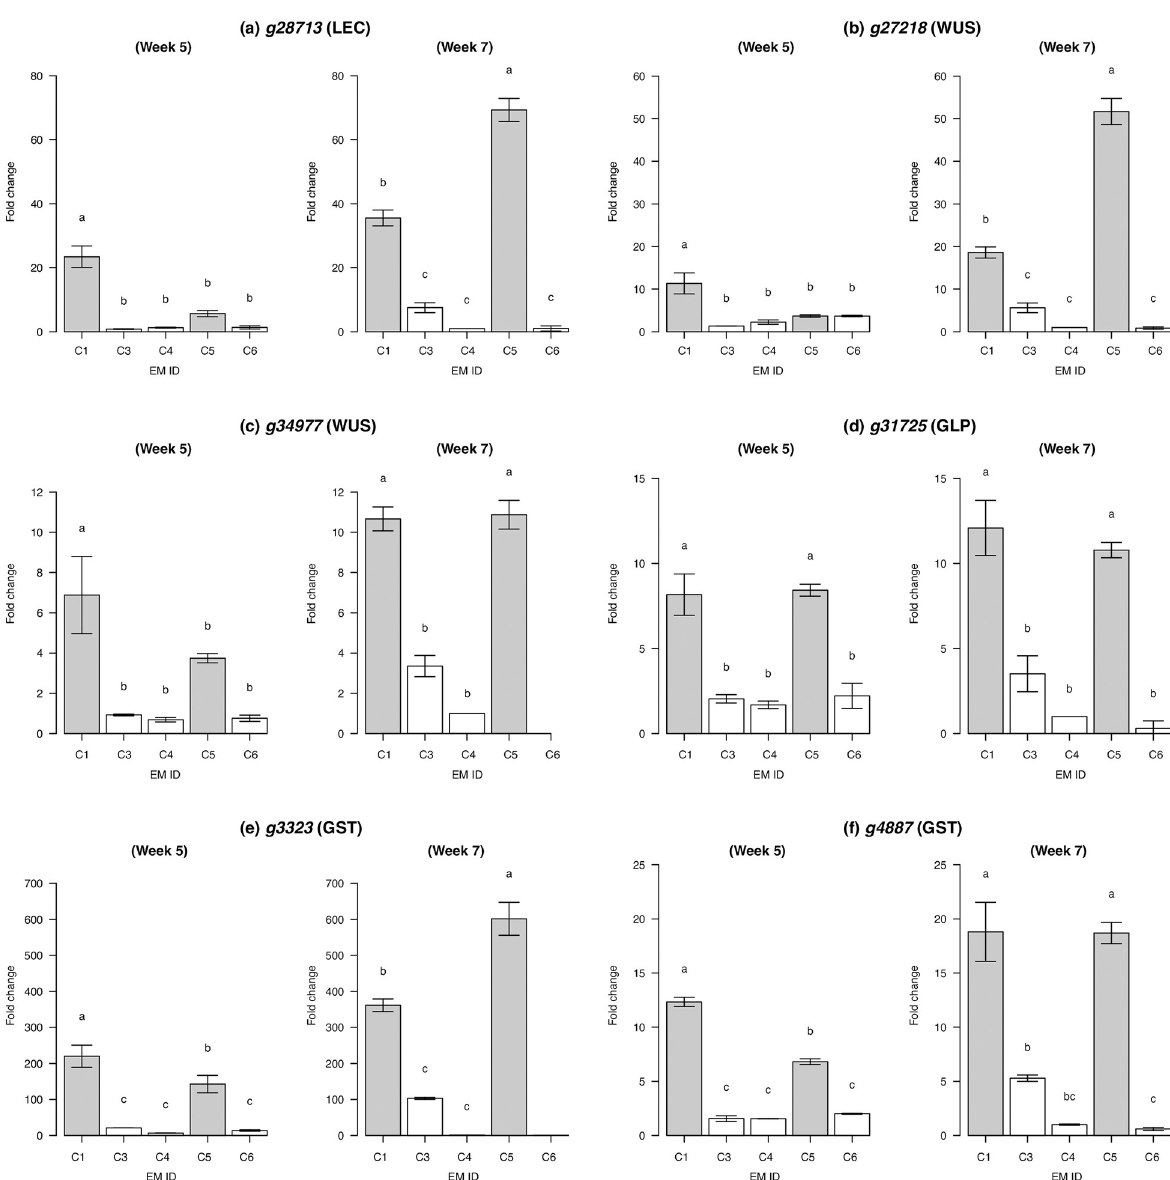
Fig 3. Relative expressions of putatively embryogenesis-related genes in Cryptomeria japonica . Expressions of six genes encoding (a) leafy cotyledon (LEC), (b, c) wuschel (WUS), (d) germin-like protein (GLP), and (e, f) glutathione-S-transferase (GST) were quantitated. For each gene, expression levels were normalized with that in C4 from the 7th week. Means with different letters are significantly different (Tukey’s multiple comparison test, p < 0.01). Samples with high embryogenic potential (C1 and C5) were indicated in gray. In C6 from the 7th week, the expressions of (c) g34977 and (e) g3323 were not quantified due to the low expressions.